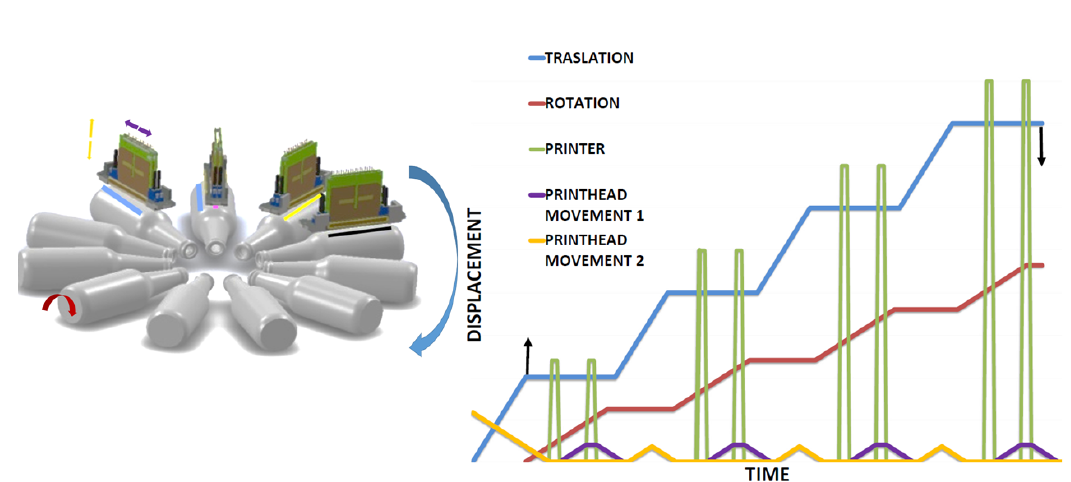
Figure 7. Topology